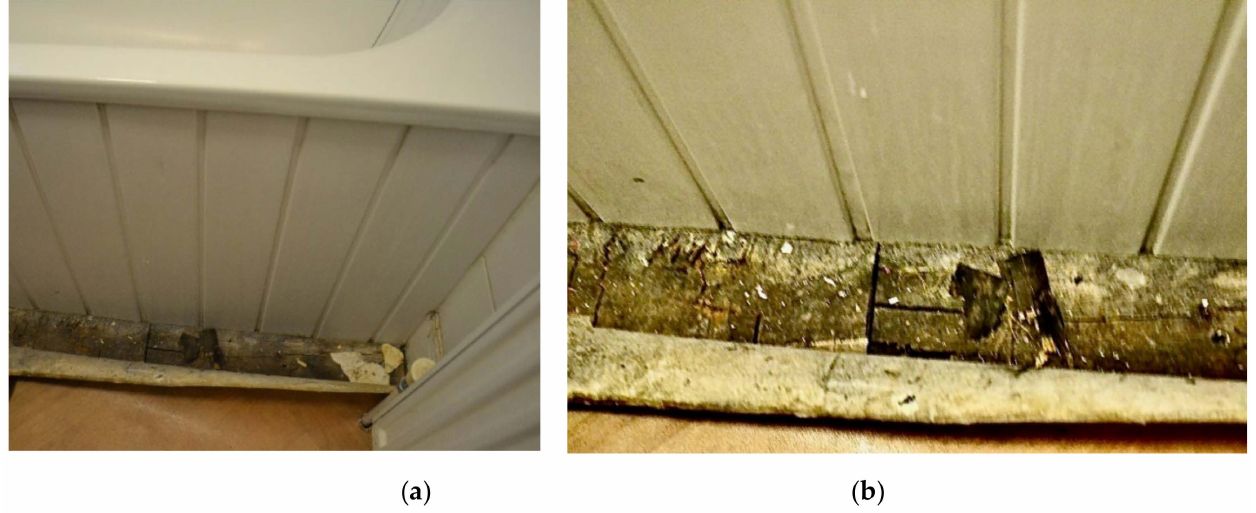
Figure 13. ( a ) House visit. ( b ) House